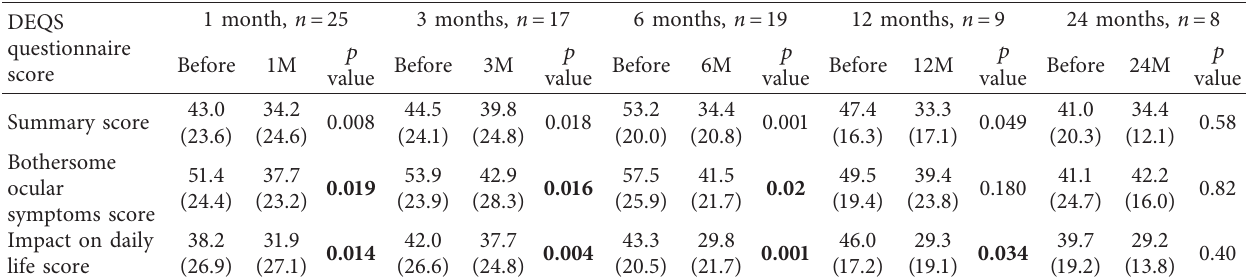
Table 2: DEQS questionnaire score at each